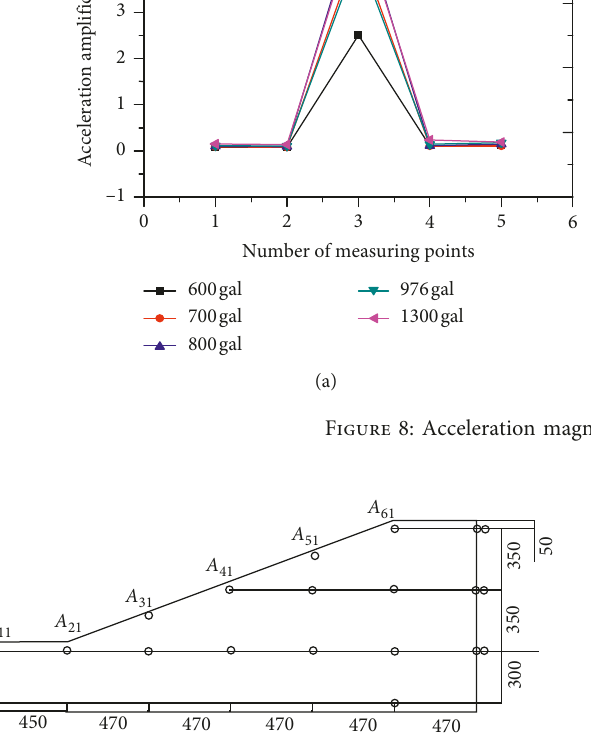
Figure 9: Cross-section of the loess slope